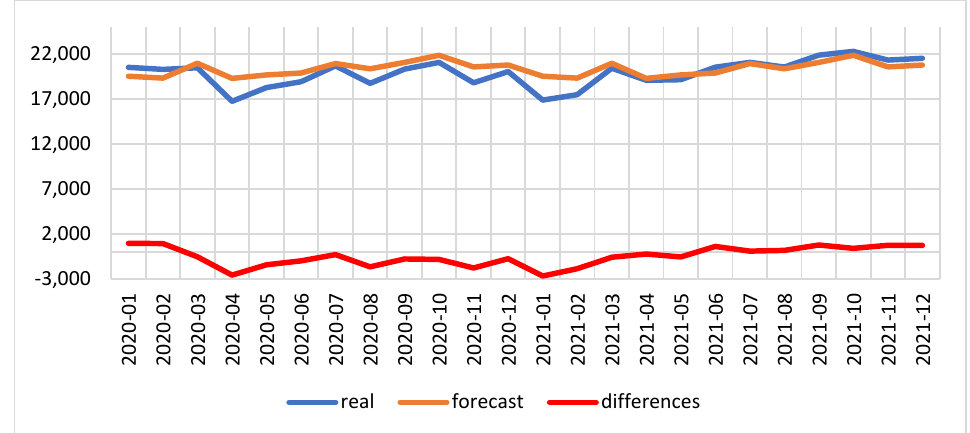
Figure 7. Comparison of the actual and forecast volumes of supplied gas oil and diesel oil (in thousand tonnes). Source: own elaboration.